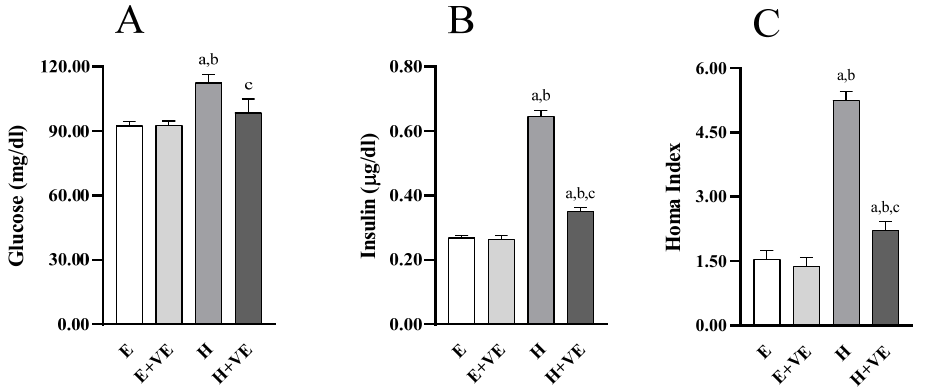
Figure 6. ( A ) left, representative western blot images of P-Akt, Akt and β -Actin in the absence ( − ) and in the presence (+) of insulin in rat liver, each line contained 30 µ g of proteins; right, P-Akt/Akt ratio in the absence (C) and in the presence of insulin (insulin). ( B ) left, representative western blot images of P-JNK, JNK and β -Actin in rat liver, each line contained 30 µ g of proteins; right, quantification of data. Values are means ± SEM of three determinations from different rats. Each determination is the mean of three independent measures. E, euthyroid; E + VE, euthyroid fed vitamin E supplemented diet; H, hyperthyroid; H + VE, hyperthyroid fed vitamin E supplemented diet. a significant vs. E. b significant vs. E + VE. c significant vs. H. The level of significance was chosen as p < 0.05.